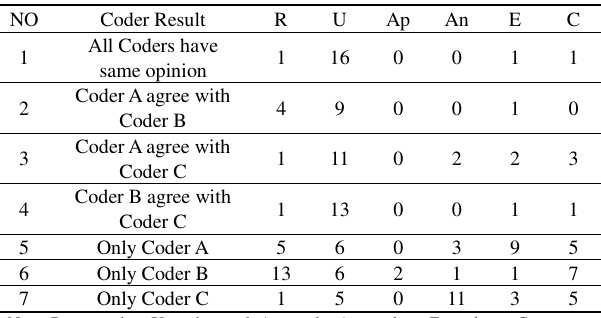
Table 2. Coding result of students’ feedback